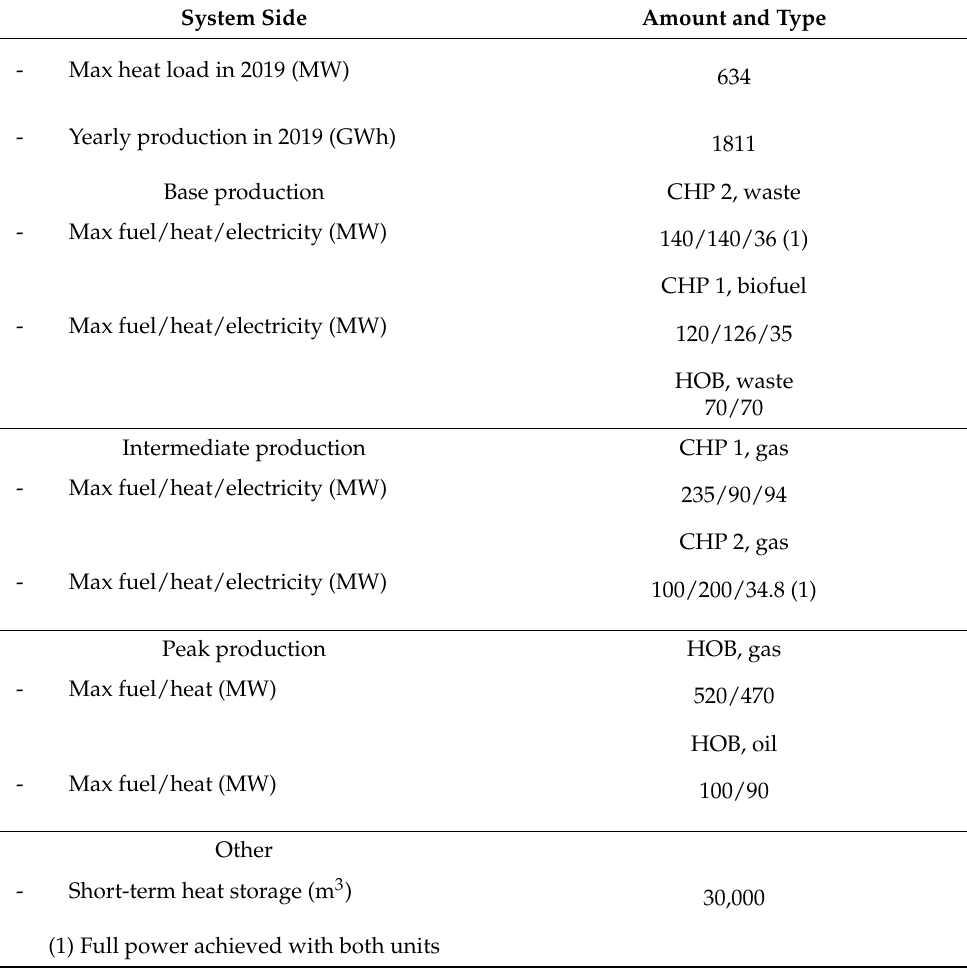
Table A1. Input values for heat production plants in